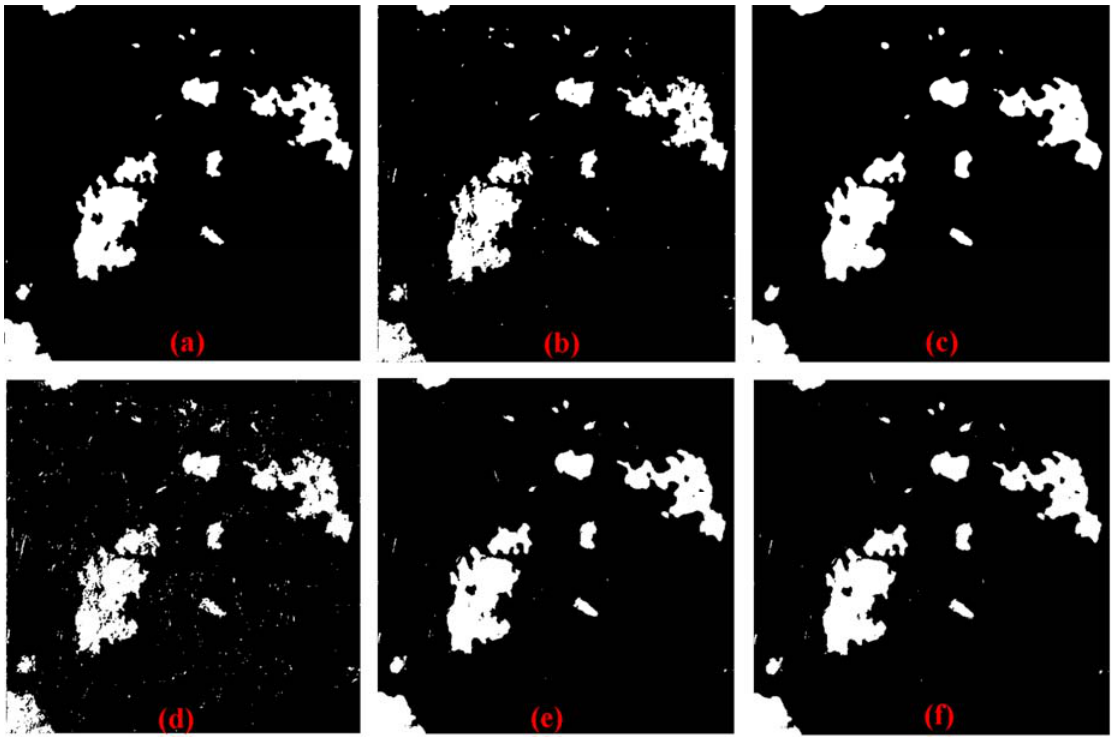
Figure 7. Mexico dataset: Binary change detection map generated by different methods: ( a ) LSELUC [45]; ( b ) MLS [46]; ( c ) PCA_Kmeans [43]; ( d ) CVA [36]; ( e , f ) the proposed approach with Otsu binary threshold and manual threshold, respectively.